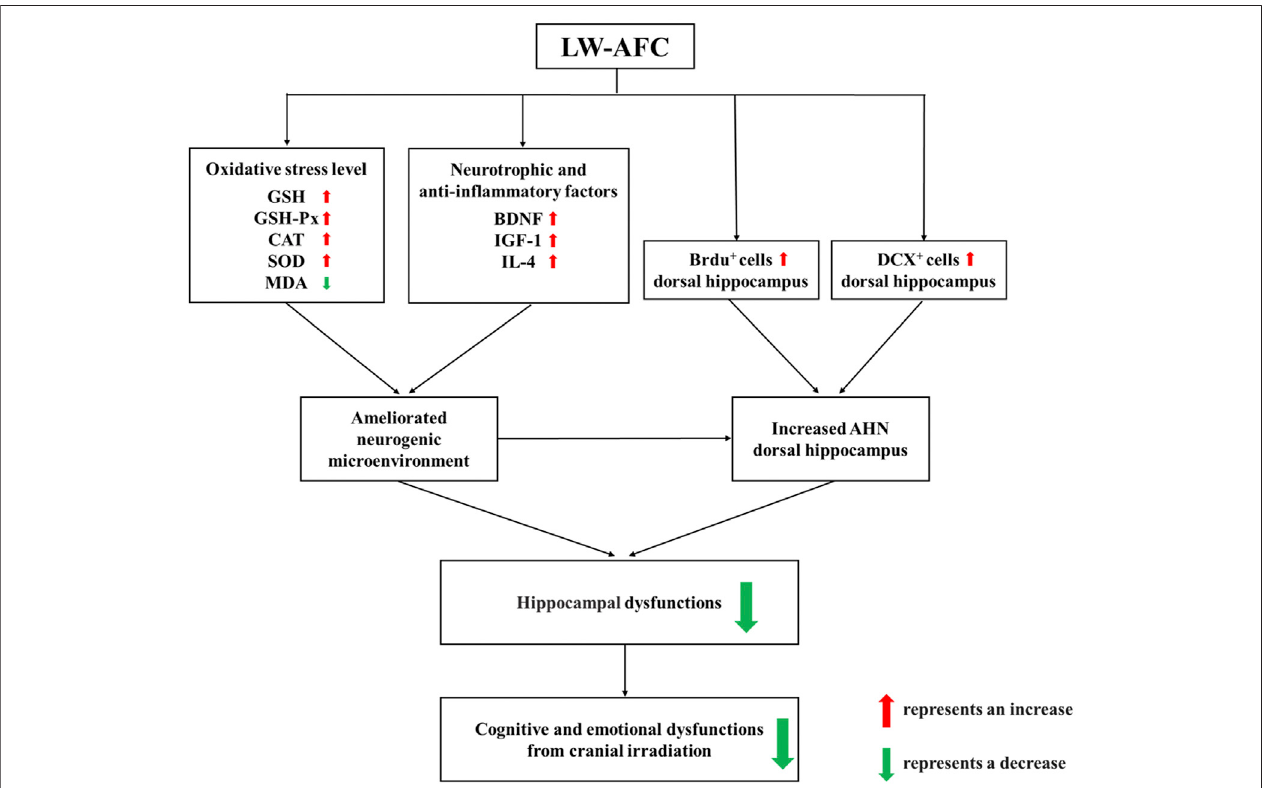
FIGURE 9 | A schematic illustration of the protective mechanisms of LW-AFC against cranial irradiation – induced cognitive and emotional dysfunctions via increasing AHN in the dorsal hippocampus and modulating the neurogenic microenvironment.